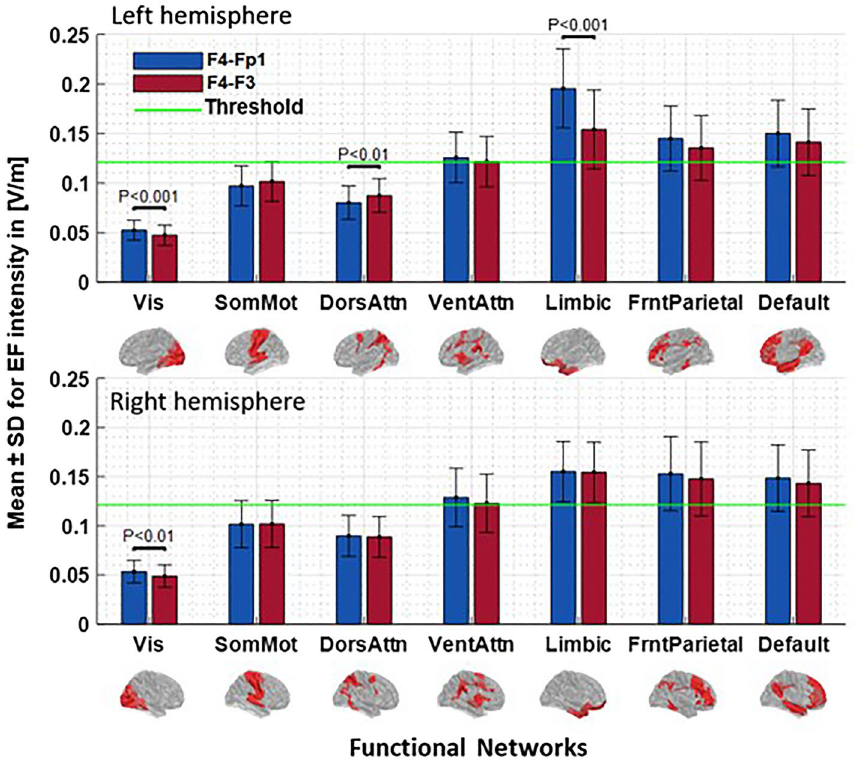
Figure 4. Parcellation of the average EF intensity at a current of 2 mA generate by each montage for the large-scale brain networks. Bars show mean value and error bars show SD of the EF intensity in volt per meter ([V/m]) across the 66 participants in each large-scale network of Yeo7-2011 atlas for F4–Fp1 (blue bars) and F4–F3 (red bars) electrode montages in the left (first row) and right hemisphere (second row). Labels below the horizontal axis determine the name of each network in Yeo7 parcellation and small brains next to the labels represent each network in fsaverage space. Significant differences between the two montages are shown above the bars based on the t-test with FDR correction threshold at P < 0.05. The horizontal green line indicates EF threshold (50% minimum value of 99th percentile of EFs in whole-brain analysis across the subjects). EF electric field, SD standard deviation, FDR false discovery rate, Vis visual network, SomMot somatomotor network, DorsAtn dorsal attention network, VentAtn ventral attention network, Limbic limbic system network, ECN executive control network, DMN default mode